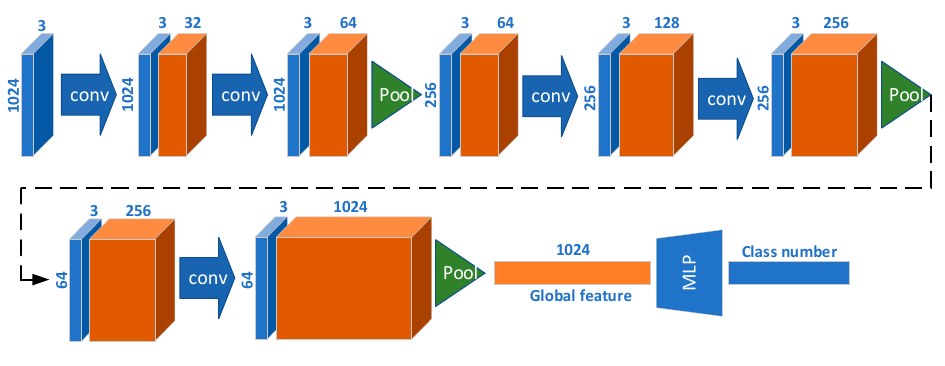
Figure 8. 3DGCN network structure.